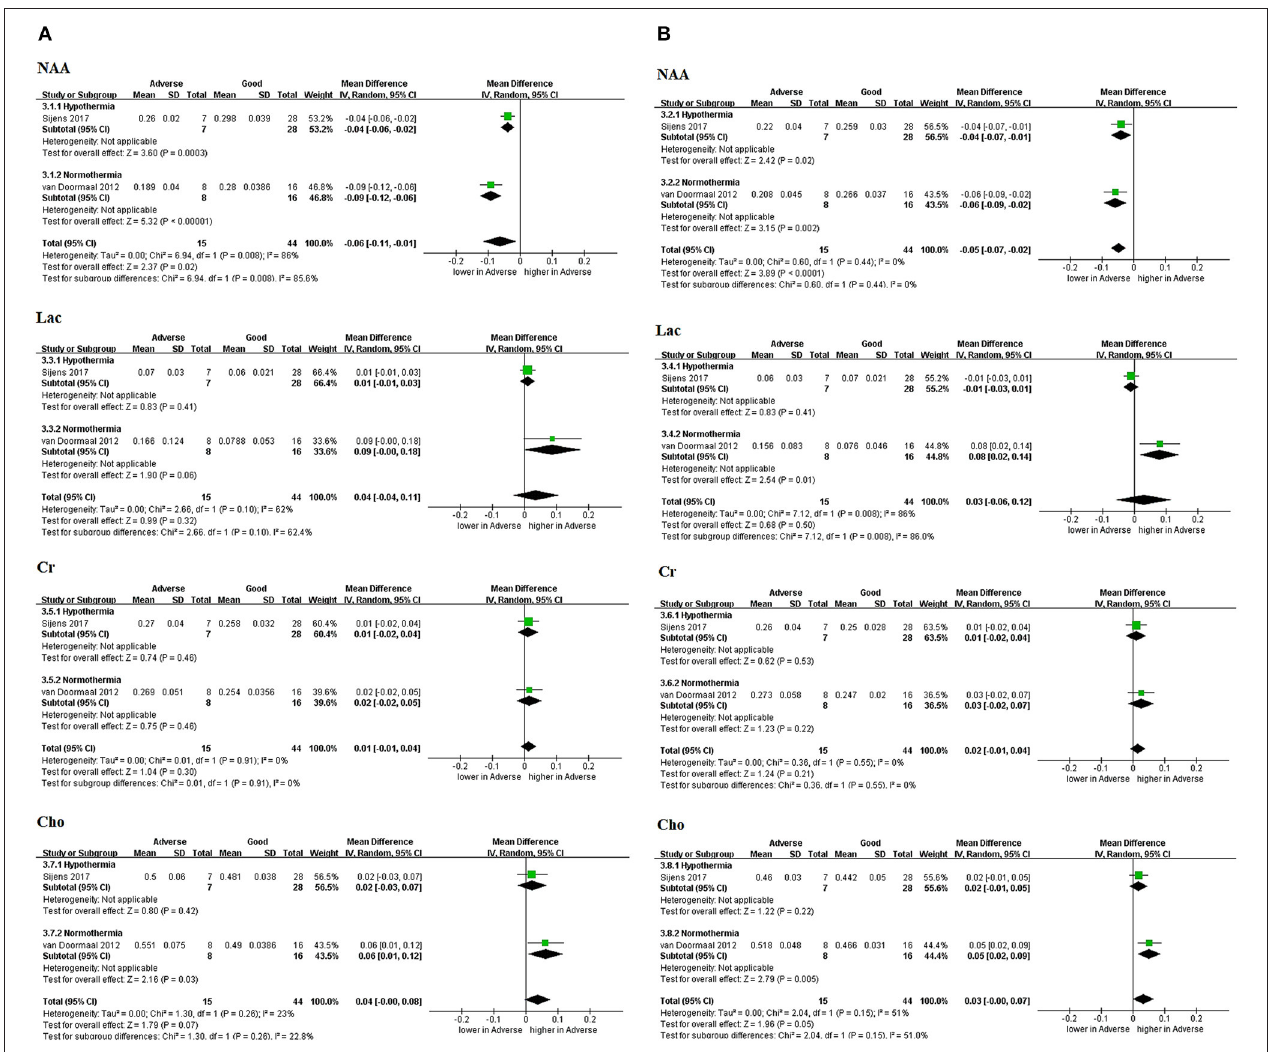
FIGURE 4 | Graphic depiction of the results of meta-analyses: relative concentration in (A) white matter and (B) gray matter (NAA, Lac, Cr, and Cho). Relative concentration of metabolites means that metabolites were expressed in percent (%) of summed peak areas of Cho, Cr, and NAA in all the analyzed voxels. Cho, choline; Cr, creatine; Lac, lactate; NAA, N-acetylaspartate.